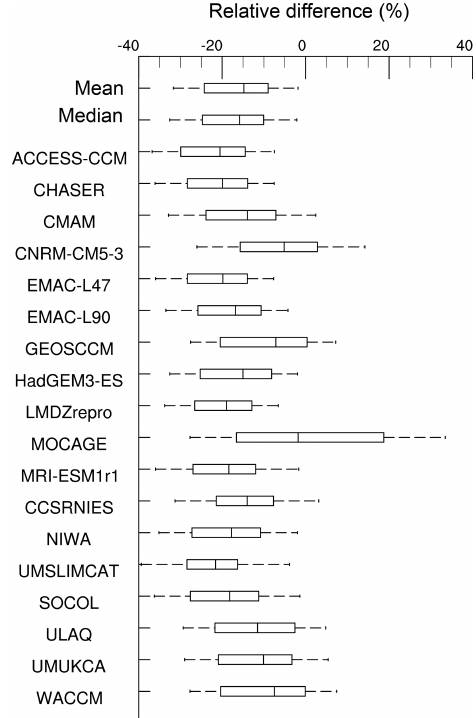
Figure 2. Box-plot summaries of the relative differences between the monthly UVI from CCMI models (refC2) and the monthly mean OMUVBd product for the period 2000–2010. Left and right ends of the box are the first and third quartile respectively. The line inside the box is the median or second quartile. Left and right ends of the whiskers are the mean ± 1 standard deviation. For a model M, (M being mean, median, ACCESS-CCM, CHASER, ...) from which we obtained UVI M , we compute − UVI OMI UVI RD [ % ] = 100 × UVI M . We then compute the average UVI OMI value of UVI RD over the entire globe and the period